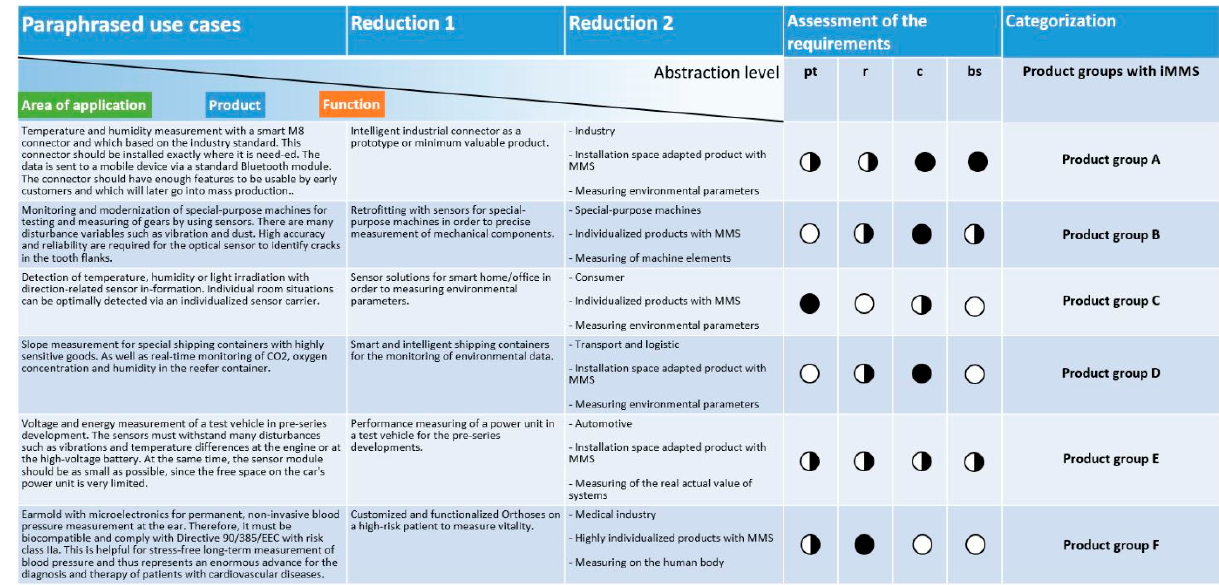
Figure 10. Inductive categorization of all analyzed iMMS use cases under consideration of requirements to create product groups.